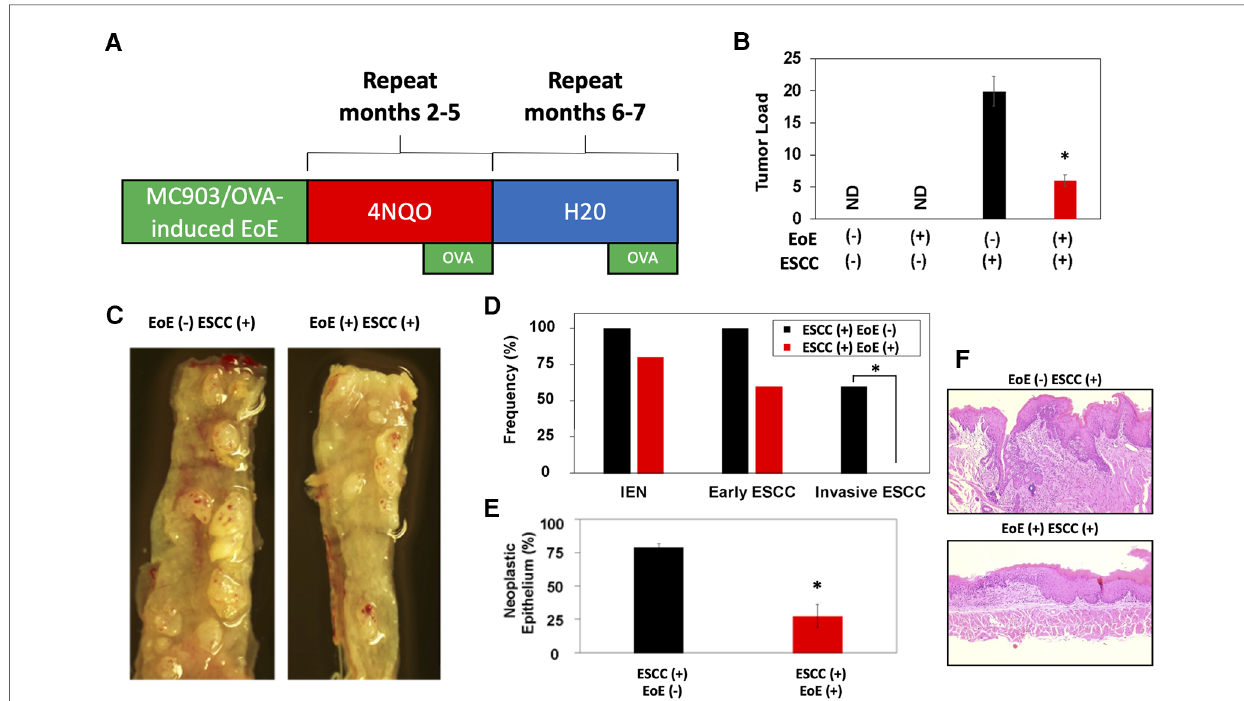
FIGURE 7 EoE in fl ammation limits esophageal carcinogenesis in vivo . ( A ) Schematic of experimental approach to combined pathology model. C57B6 mice were exposed to MC903/Ovalbumin (OVA) for one month to promote EoE, followed by exposure to the esophageal carcinogen 4-nitroquinoline 1-oxide (4NQO) to induce epithelial tumorigenesis. Esophagi were intermittently challenged with OVA to stimulate EoE-associated in fl ammation. Mice were either treated with vehicle controls ( n =6), MC903/OVA only ( n =4), 4NQO only ( n =10), or MC903/OVA in combination with 4NQO ( n =5). ( B ) Quanti fi cation of average tumor load (tumor size in mm x tumor number). ND, not detected. ( C ) Representative esophagi of mice treated with MC903/OVA to promote EoE and/or 4NQO to induce carcinogenesis. ( D,E ) Histological assessment was performed to quantify frequency of esophageal lesion types in ( D ) and percent of esophageal epithelium occupied by neoplastic lesions (squamous dysplasia or greater) with representative images shown in ( E ). *, p <0.05 as calculated by unpaired student ’ s t-test in ( B ) and ( E ) or Fisher ’ s exact test in ( D